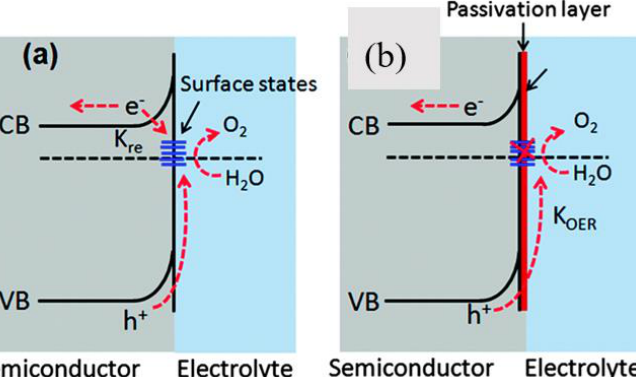
Figure 6. The band structures of an n-type semiconductor photoanode ( a ) without and ( b ) with a passivation layer. ( a ) High charge recombination happening at surface defects and thus inefficient water oxidation by the photo-generated holes; ( b ) use of thin non-catalytic passivation layers which suppress surface recombination and improve water oxidation. Adapted from Reference [14], copyright (2016) Royal Society of Chemistry.